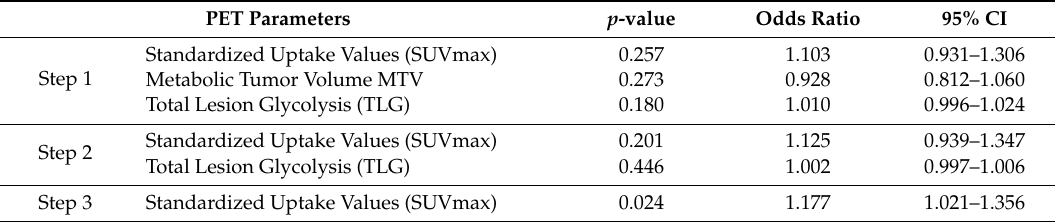
Table 2. Associations with PET to Overall